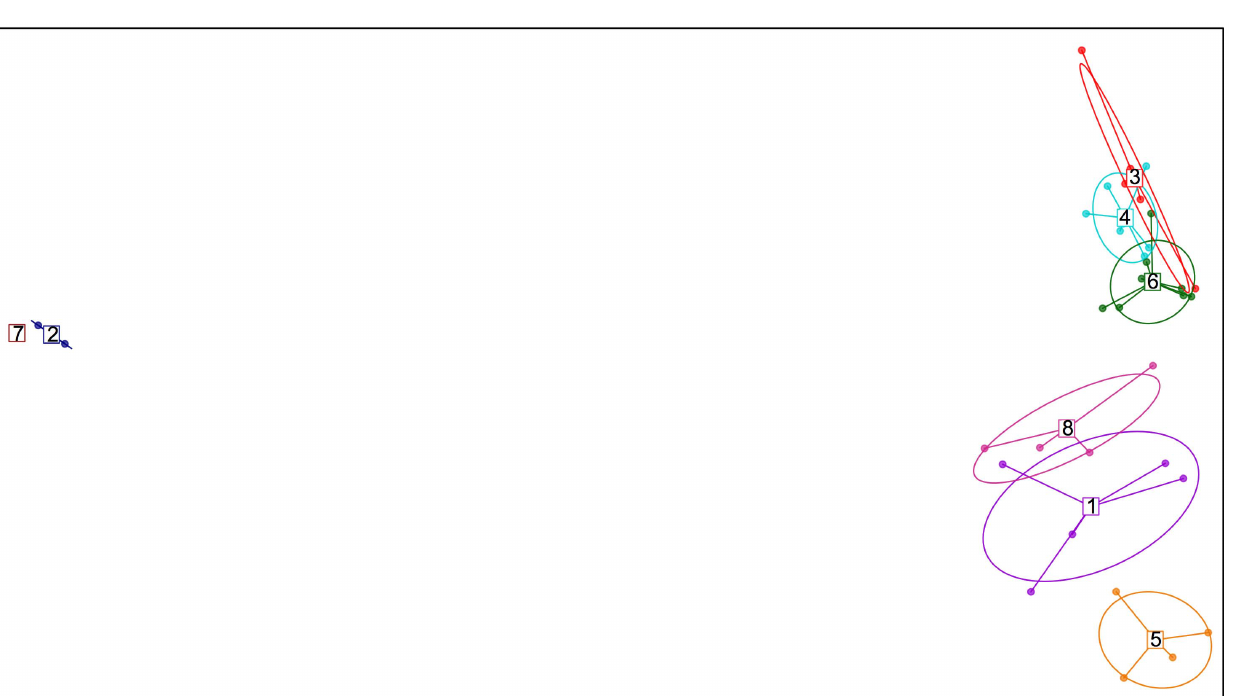
Fig. 3. Discriminant Analysis of Principal Components (DAPC) using 12 microsatellite loci. This scatterplot shows the first two principal components of the DAPC of Phytophthora infestans genotypes found in the United States. Groups are shown by different colors and inertia ellipses, while dots represent individual strains. Cluster 1 includes lineages US-6, US-7, US-11, US-12, and US-16; Cluster 2 includes isolates in lineage US-23; Cluster 3 includes lineages GDT-02, GDT-07, GDT-13, GDT-18, and GDT-20; Cluster 4 includes lineages GDT-03, GDT-04, GDT-08, GDT-08.1, GDT-14 and GDT-15; Cluster 5 includes lineages US-8, US-14, US-20, and US-24; Cluster 6 includes lineages GDT-05, GDT-06, GDT-09, GDT-10, GDT-11, GDT-12, GDT-16, GDT-17, and GDT-19; Cluster 7 includes lineages US-1; and Cluster 8 included lineages US-17, US-19, US-21 and GDT-01.